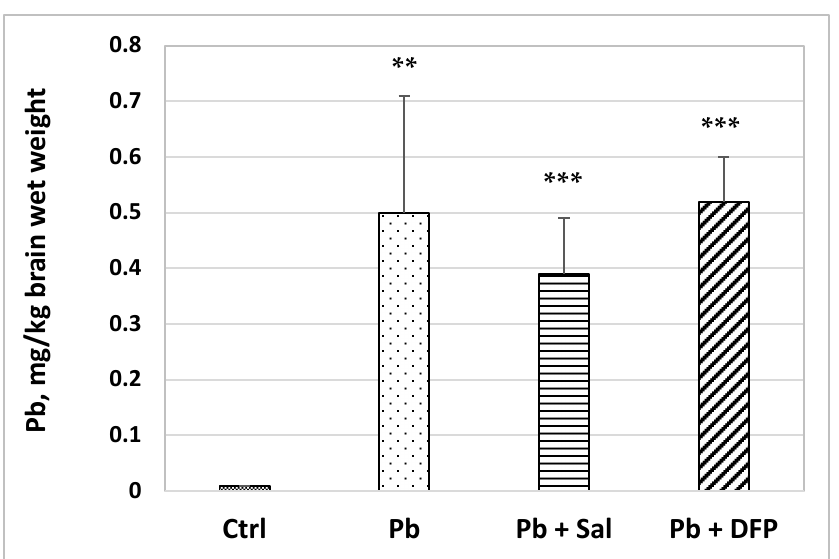
Figure 2. Pb concentration in the brains of experimental mice: Ctrl—untreated control group; Pb—Pb-exposed group; Pb + Sal—Pb-intoxicated mice treated with salinomycin; Pb + DFP—Pb-intoxicated mice treated with deferiprone. Data are presented as mean + SD. ** p < 0.01, *** p < 0.001 compared with the untreated control group.